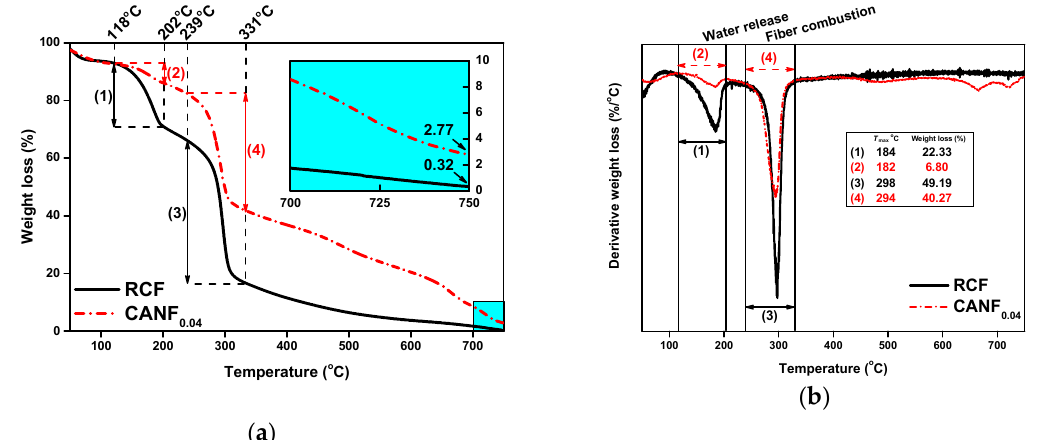
Figure 9. Thermal stability of composite films: ( a ) TG curves of RCF and CANF 0.04 and ( b ) DTG curves